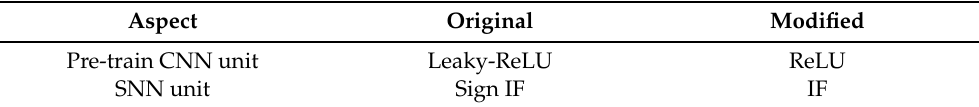
Table A1. Some modifications made for implementing the conversion method in Kim et al.’s method [27].